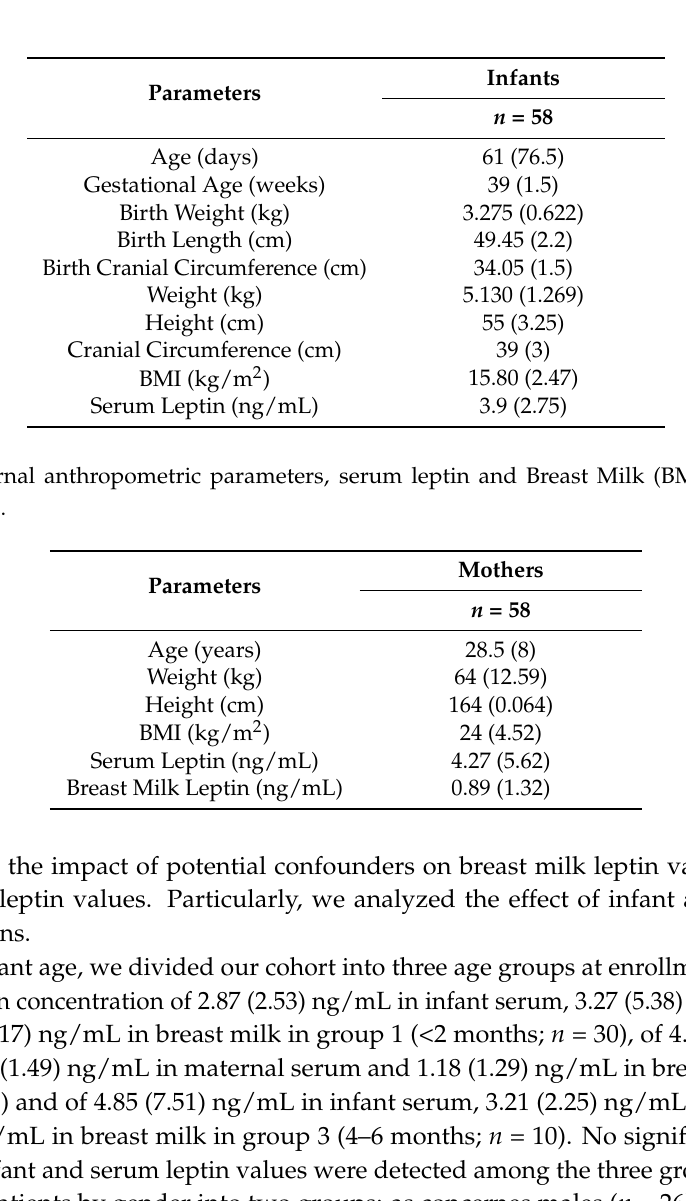
Table 1. Infant anthropometric parameters and serum leptin values (median + interquartile range (IQR)).